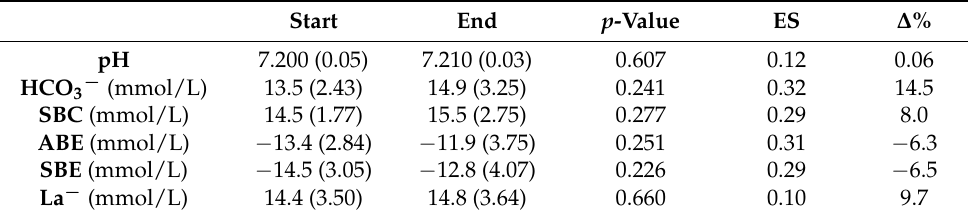
Table 4. Changes in acid-base status markers (ABL 90) during the off-season period in well-trained cyclists. Start End p -Value ES ∆ % pH